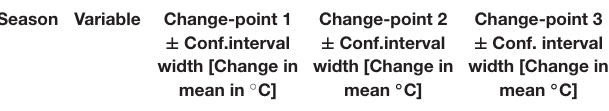
TABLE 3B | Change-points in mean for station FIA representing interior region of Alaska with: PELT change-point estimate ± width of approximate 95% confidence interval (when change detection test p -value < 0.05) and [amount of change in mean in ◦ C], or only PELT change-point estimate (when change detection test p -value >